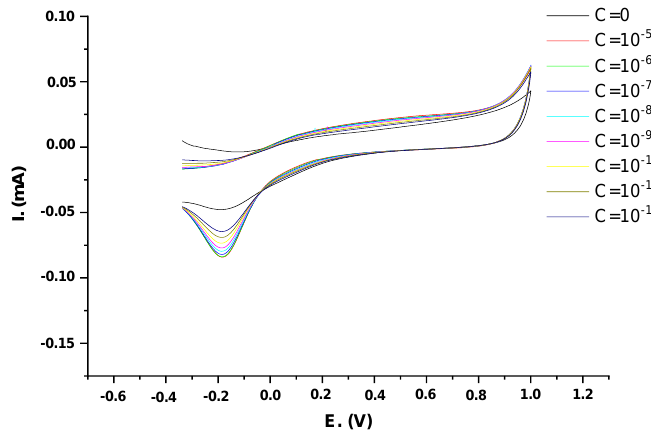
Figure 6. CV voltammograms of various AMD concentrations in 5 mM PBS at pH 7.4.